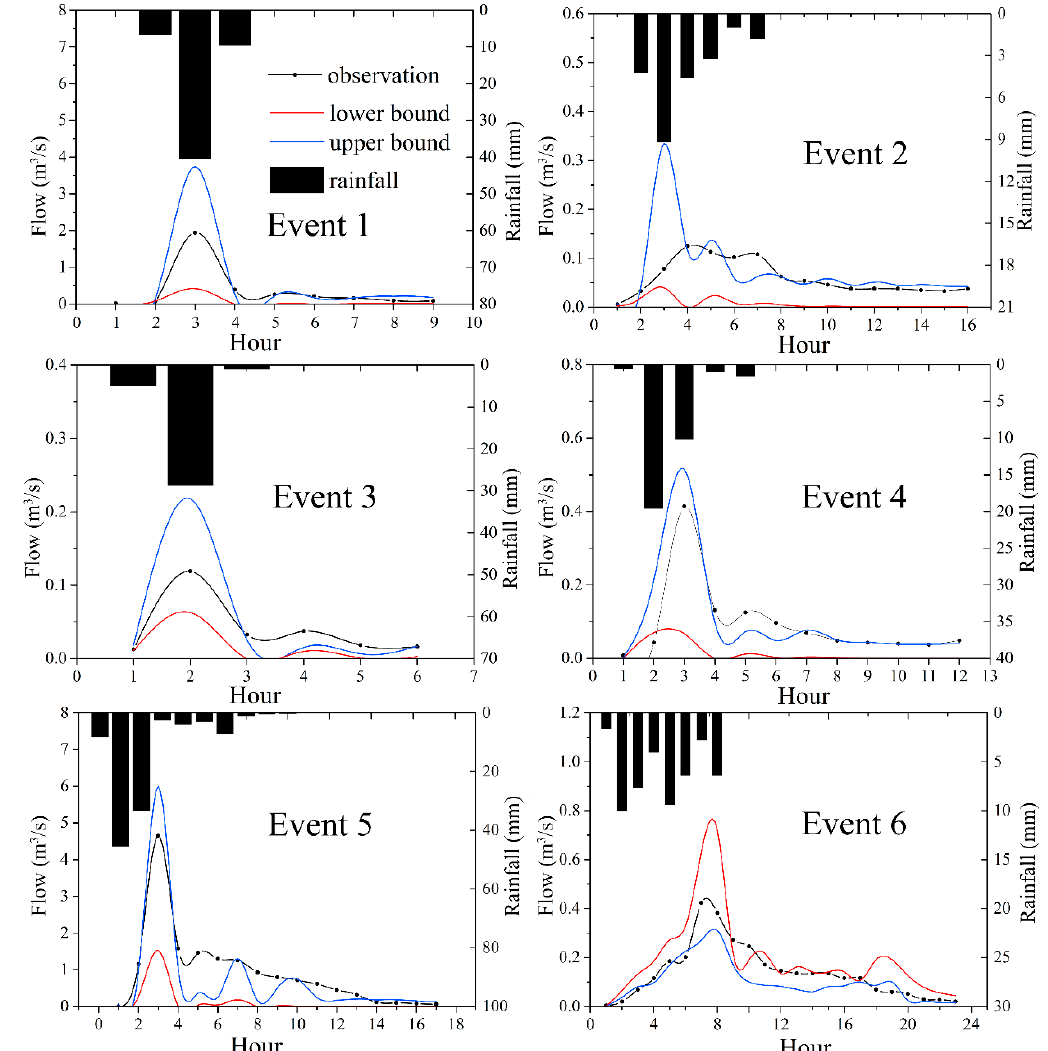
Figure 10. Observations and 95 PPU bounds of streamflow in the continuous modeling. The left and right parts present results of daily and monthly simulation, respectively.